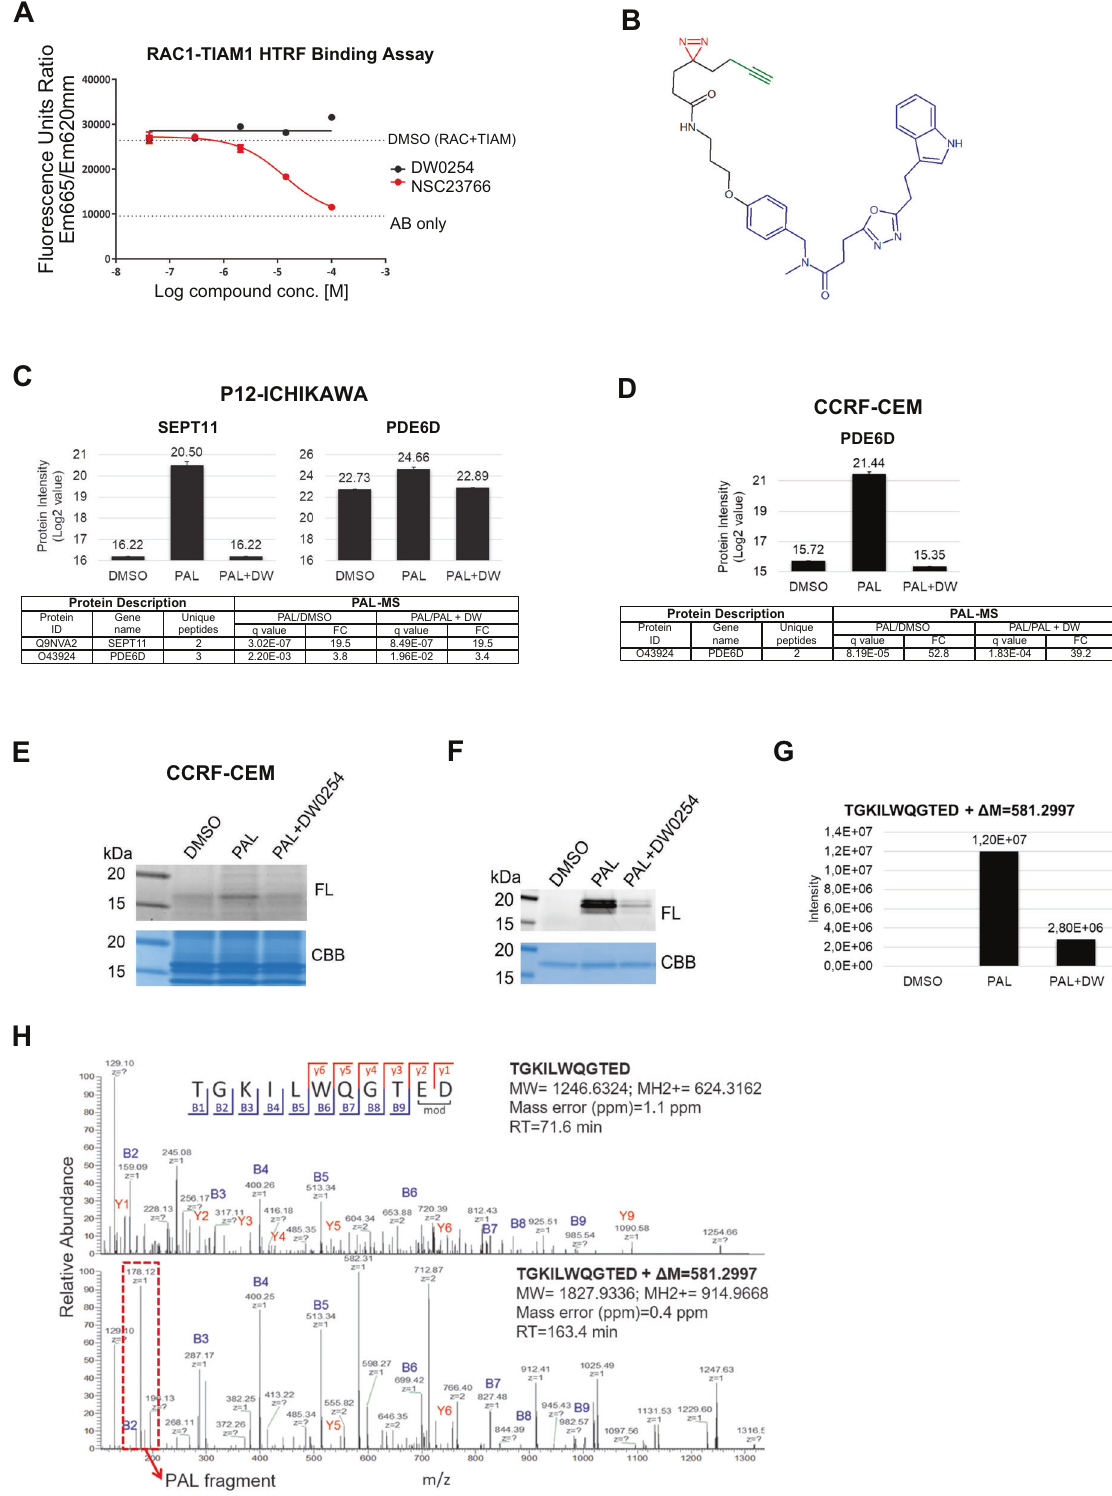
reported to bind in PDE6D ’ s hydrophobic pocket and inhibit the growth of pancreatic cancer cell lines [23]. Since our data suggests the same binding site for DW0254, we tested DW0254-treated PDE6D-edited cells for sensitivity to Deltarasin. While unedited cells displayed a higher IC 50 to Deltarasin (gray in Fig. 4E) when compared to DW0254 (gray in Fig. 4D), DW0254-treated